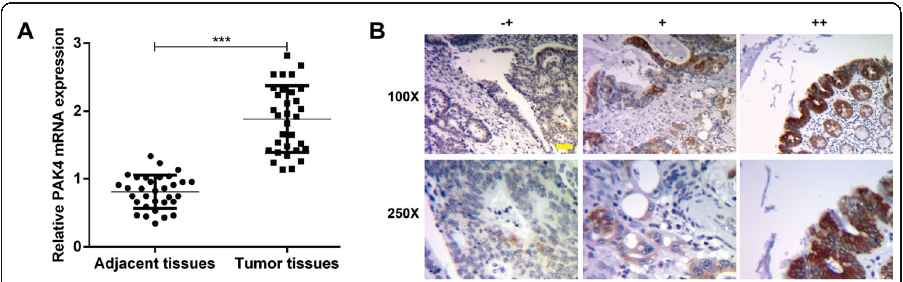
Fig. 1 The expression of PAK4 mRNA and protein in CRC tissues. a The expression of PAK4 mRNA was determined using quantitative real-time PCR in 32 pairs of CRC tissues and adjacent non-cancerous tissues. *** p < 0.001; b Representative immunohistochemical staining of PAK4 in CRC tissues and non-cancerous colorectal mucosa ( − +, weak staining, + moderate staining, ++ strong